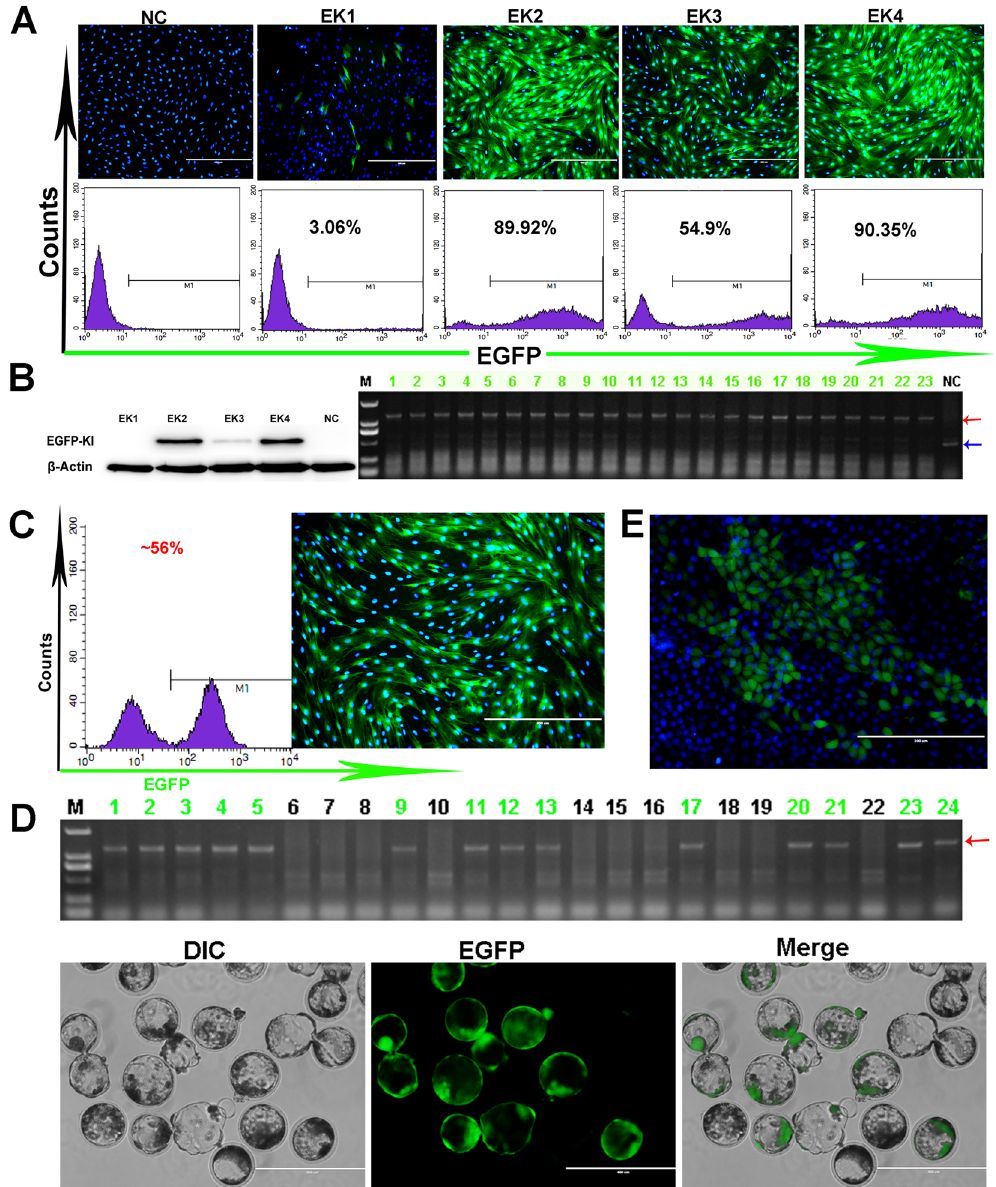
Figure 5. Application of the EGFP-KI reporter PFFs. ( A ) The purity of each EGFP gene site-specific knock-in cell clones was analysed via fluorescence microscopy and confirmed via FACS. ( B ) To confirm of the purity of each cell clone by western blotting (shown on the left); Genomic PCR analysis of the blastocysts (shown on the right); these 23 nuclear donor cells were derived from cell clone-EK4. The results show the high purity of cell clone-EK4. The red arrow indicates the knock-in bands and the blue arrow indicates the wild-type bands. NC: negative control. ( C ) The proportion of mixed nuclear donor cells was analysed via fluorescence microscopy and confirmed via FACS. ( D ) Genomic PCR analysis of the blastocysts (upper). Nuclear donor cells were derived from the mixed nuclear donor cells in fig. C . The red arrow indicates the knock-in bands. After 7 days of culture, the mixed blastocysts were observed by fluorescence microscopy (lower). M: D2000. ( E ) Generation of the EGFP reporter PK-15 cell lines was confirmed via fluorescence